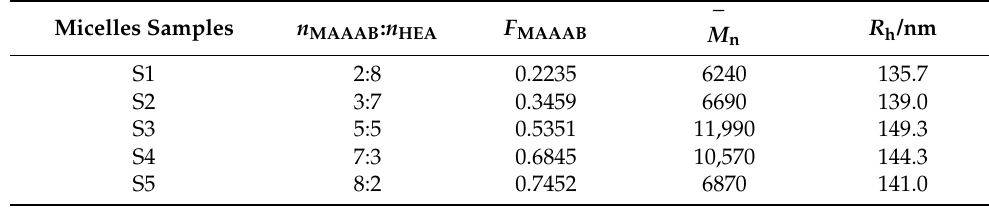
Table 2. Hydrodynamic radius of copolymeric